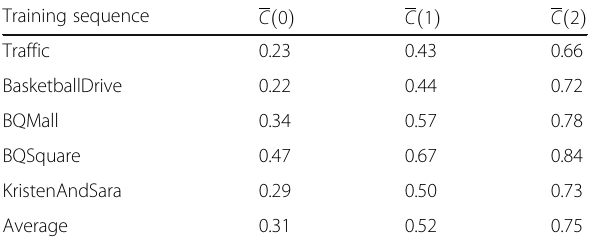
Table 1 Mean normalized coding complexity of four QPs at different maximal depths Training sequence